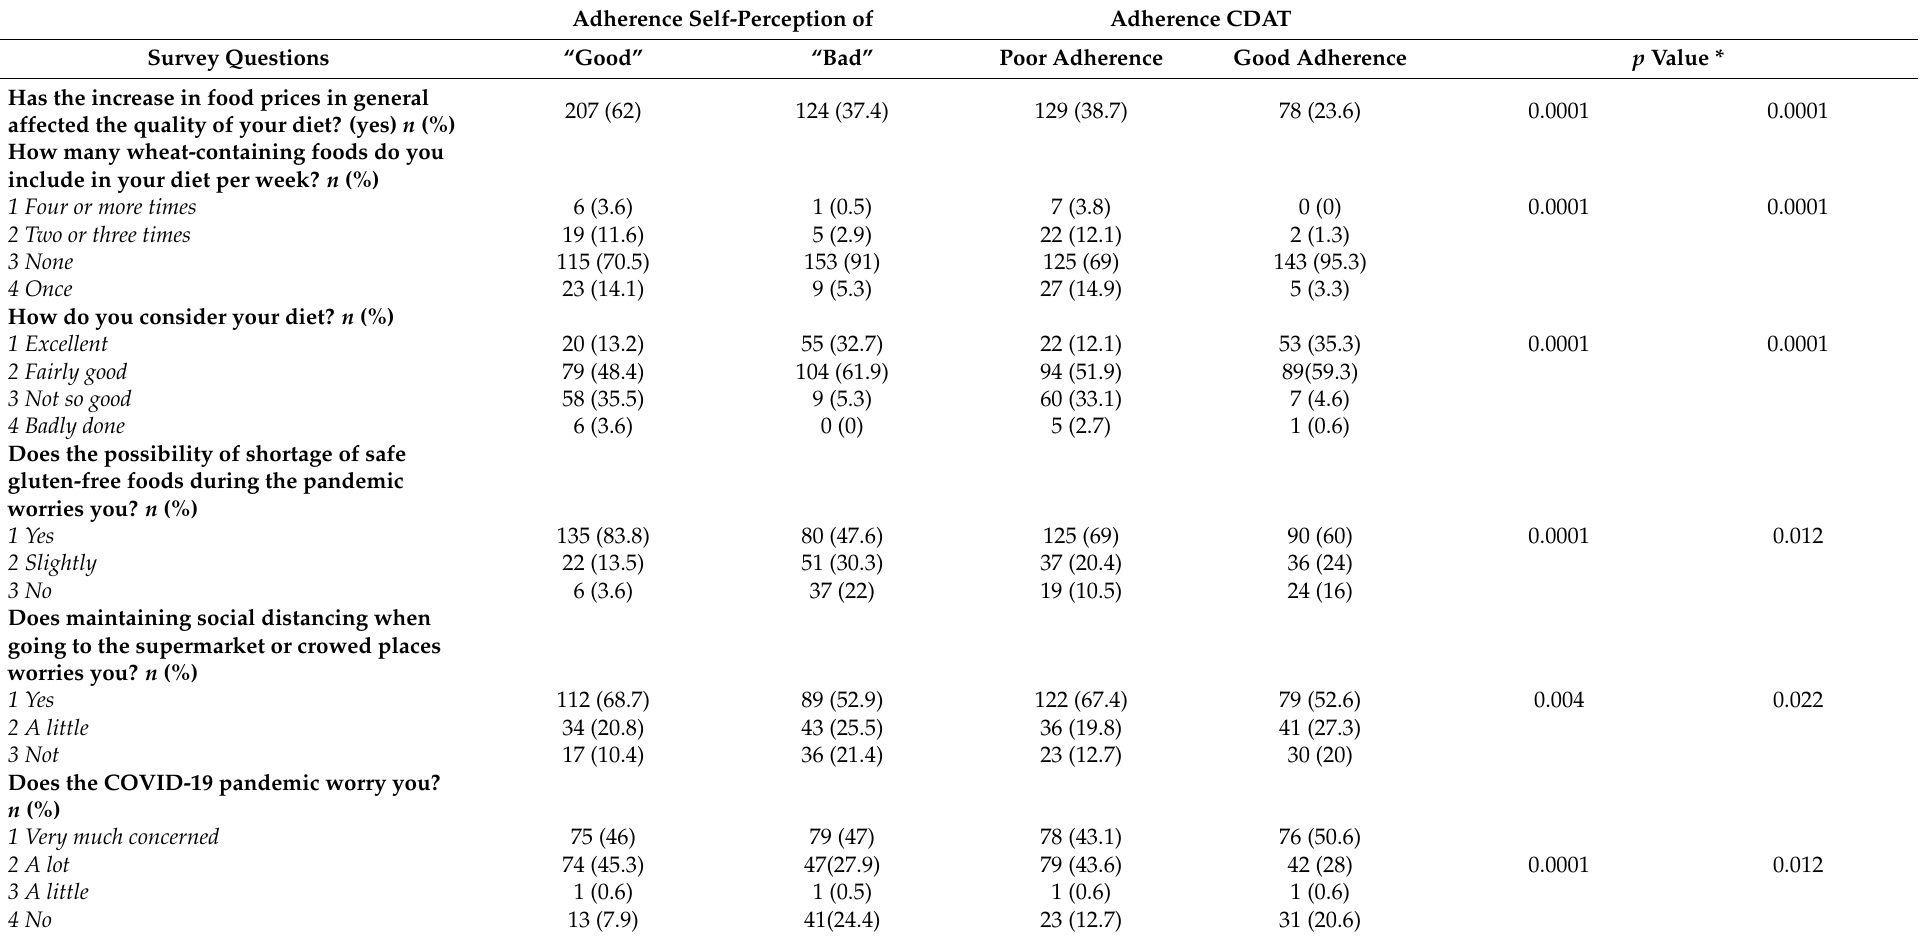
Table 3. Self-perception of COVID-19 pandemic effects on gluten-free diet and celiac disease test adherence (CDAT). Adherence Self-Perception